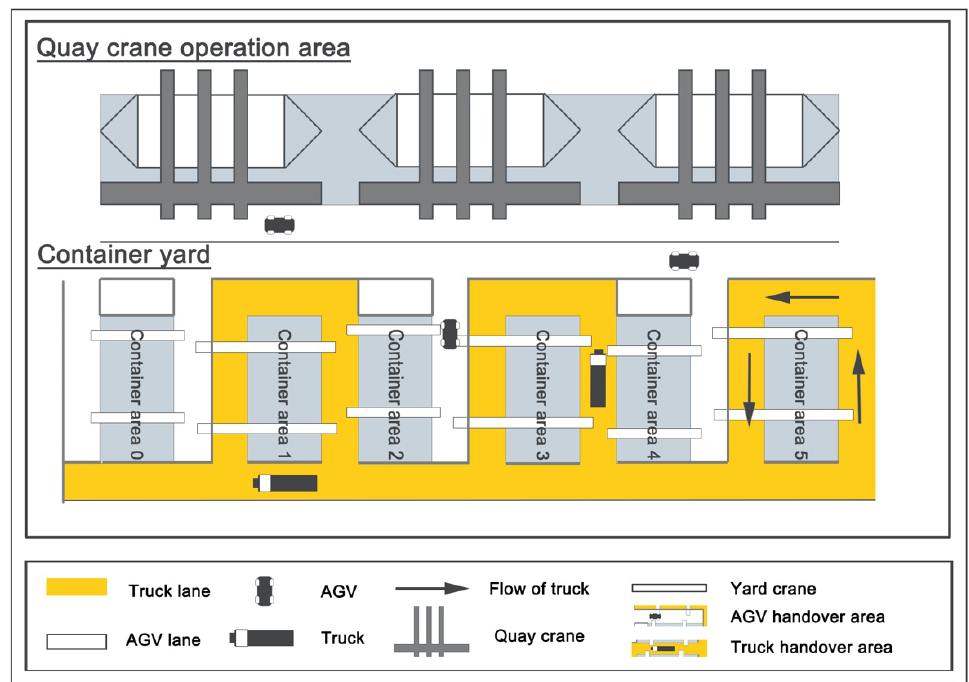
Figure 2. U-shape trafficked automated terminal.